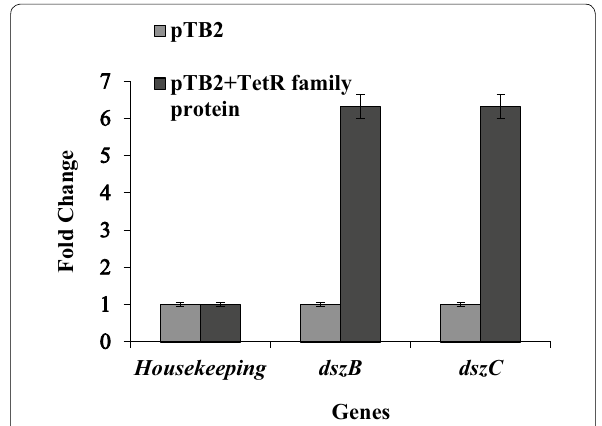
Fig. 4 Graph representing an increase in expression of dsz genes ( dszB and dszC ) in presence of TetR family protein through RT-PCR. The experiment was performed in triplicates and repeated